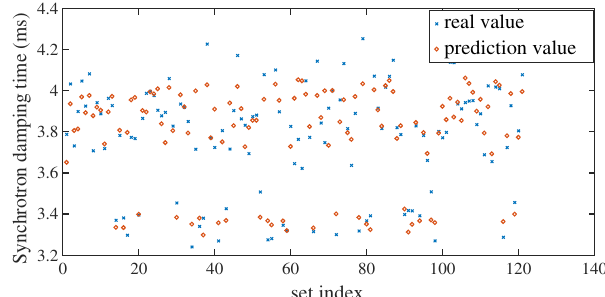
FIG. 6. Predictive value versus test value about synchrotron damping time. Blue mark:test value; orange mark: predictive value.